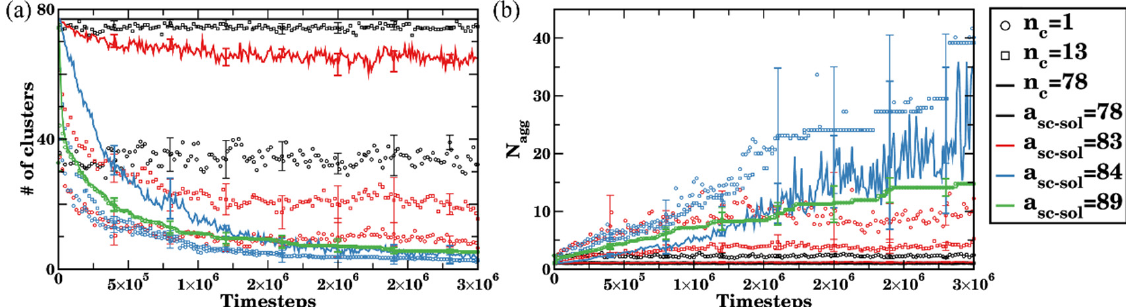
Figure 6. Time evolution of ( a ) number of clusters, and ( b ) aggregation number N agg for a sc-sol = 78 (Case I, in black), a sc-sol = 83 (Case II, in red), a sc-sol = 84 Case (III, in blue), and a sc-sol = 89 (Case IV, in green). Circles, squares, and solid lines of the same color represent the number of contacts used to identify clusters (n c = 1, 13, and 78, respectively). The data are averaged over n MBB = 77 bottlebrushes in four independent simulation sets for each time step, the error bars represent standard deviation.